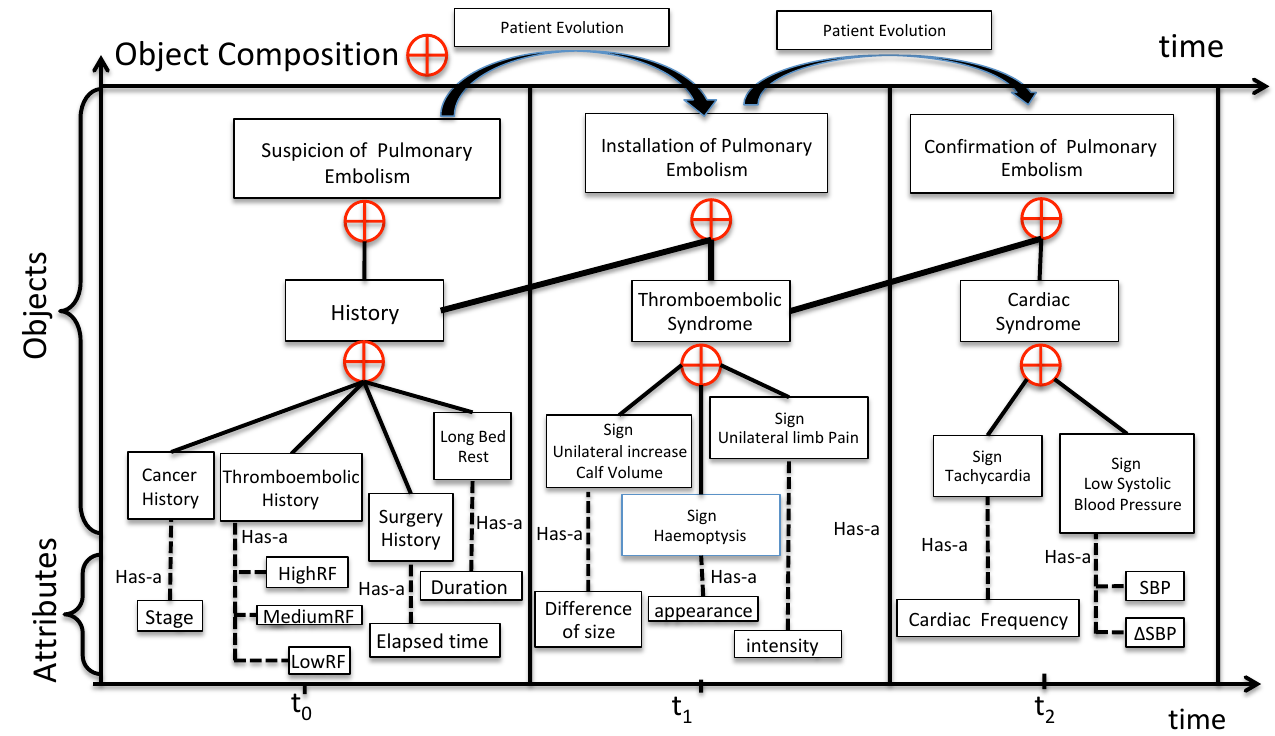
−−−→ PE ( t ) is the resultant of the vectors −−−→ HIST (history) is static and